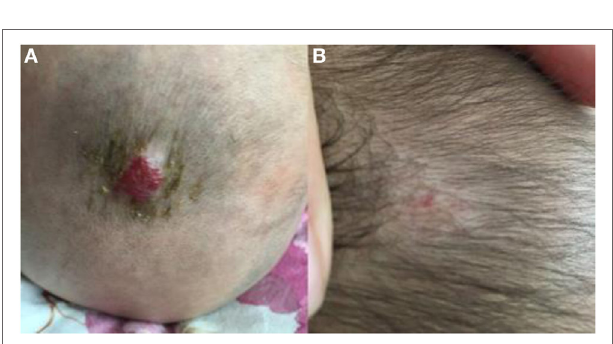
FigUre 2 | Response of superficial infantile hemangiomas in the periorbital area to topical timolol maleate 0.5% hydrogel. (a) Before starting topical timolol therapy, at the age of 2 months; (B) at the age of 14 months after end of topical timolol therapy; obvious discoloration was noted.